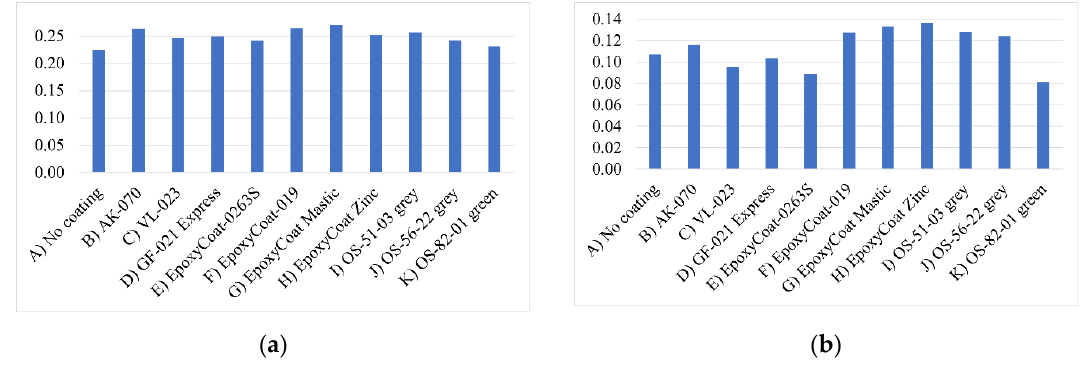
Figure 4. The variation coefficient of: ( a ) peak short circuit current; ( b ) mean arc current.